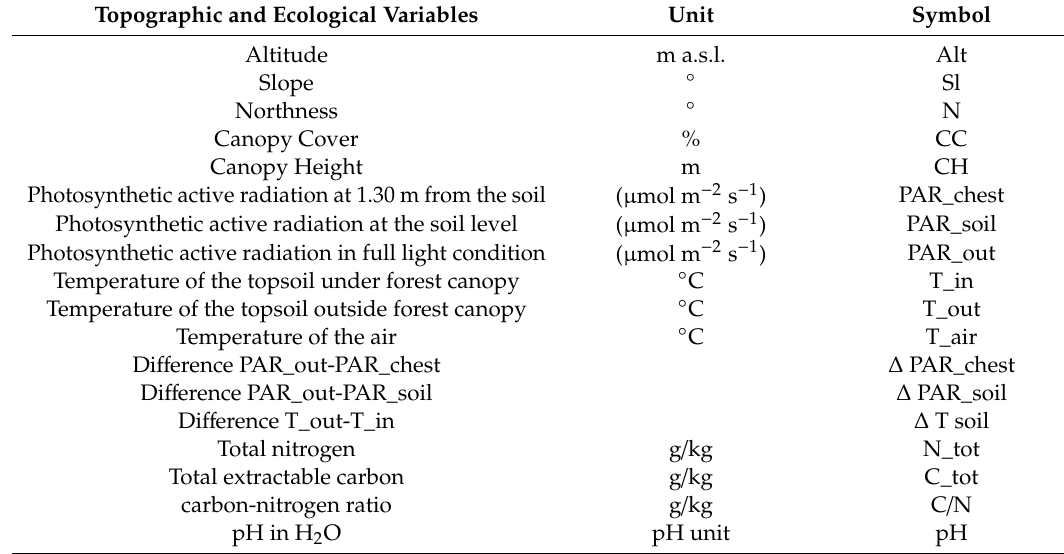
Table 3. Measured variables. Description of the topographic characteristics and ecological variables considered, with the indication of the unit and the respective symbol for each